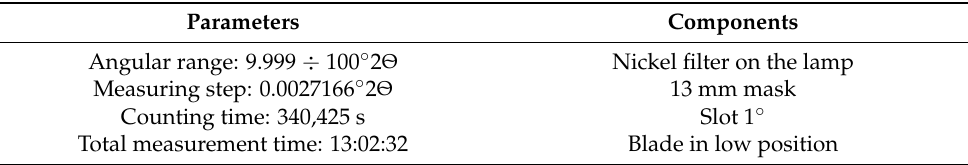
Table 3. X-ray diffraction (XRD) analyzer settings.